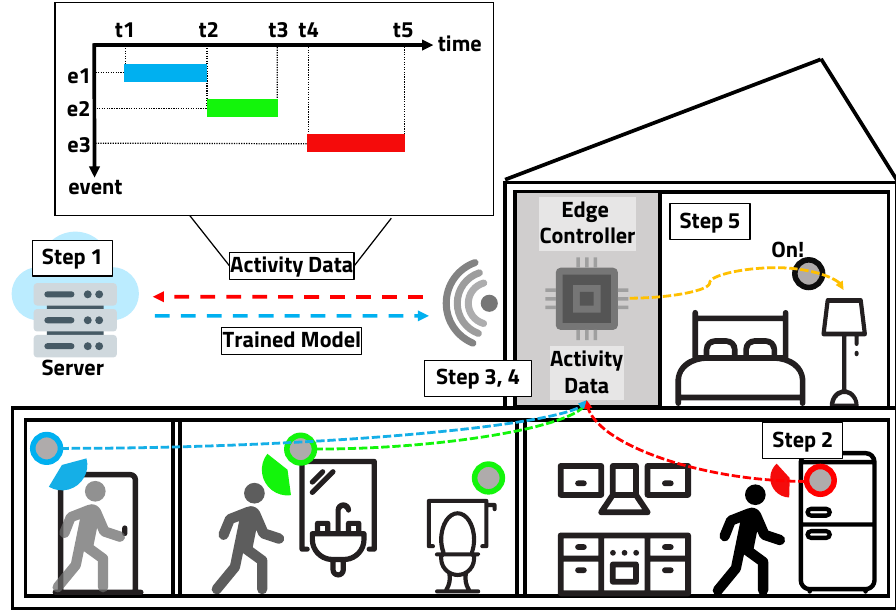
Figure 1. Overview of the smart home